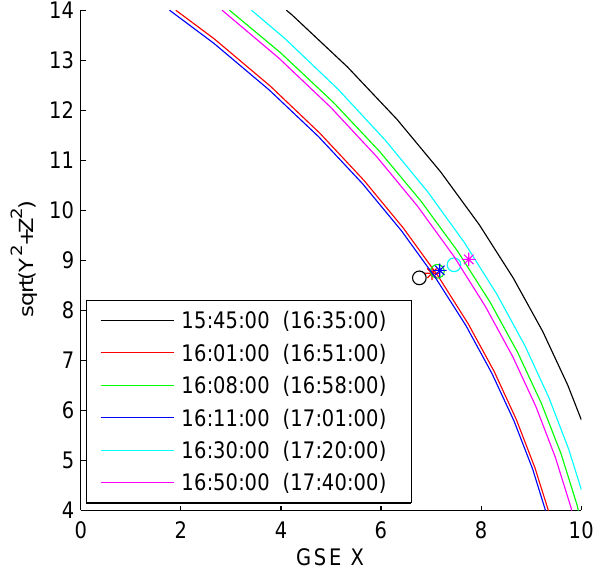
Fig. 8. Location of magnetopause obtained from the model of Shue et al. (1998) and Cluster at certain times of interest: Before the first ion flow event a (16:35 UT, black), in ion flow event a (16:51 UT, red), after ion flow event a (16:58 UT, green), in second ion flow event b (17:01 UT, blue), after ion flow event b (17:20 UT, cyan) and in third ion flow event c (17:40 UT, magenta). The curves show magnetopause locations at ACE times and symbols (stars for times in ion flow events and circles for times outside the events) show Cluster locations at Cluster times (in brackets). Cluster and MP positions are shown in same